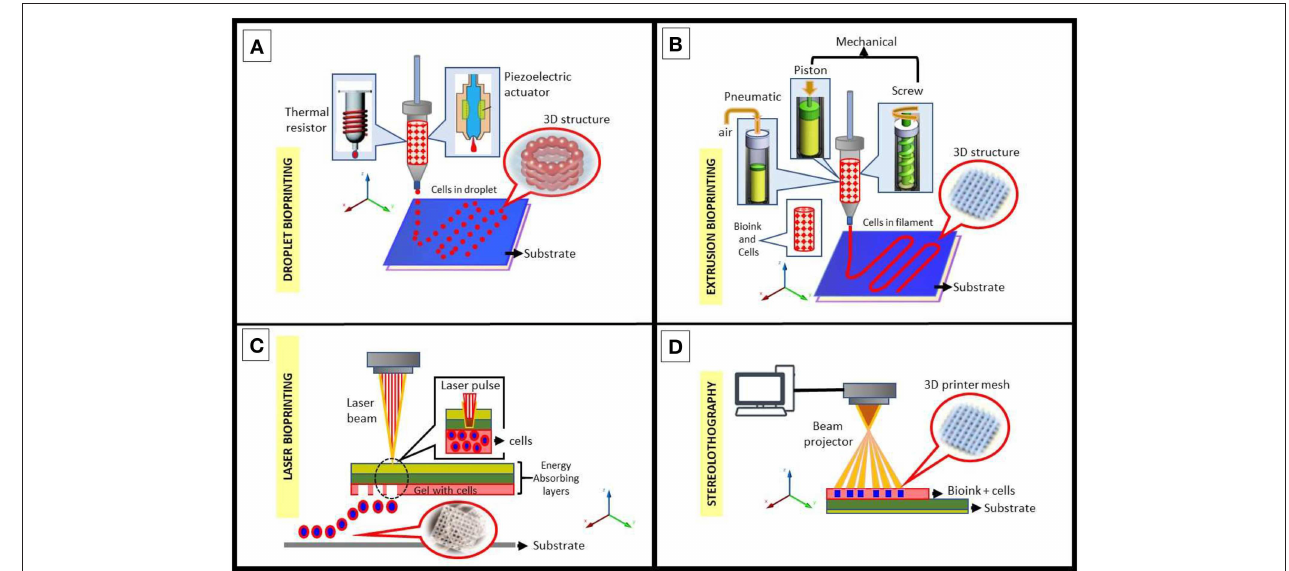
FIGURE 2 | Schematic diagram of common bioprinting methods using bioinks (with and/or without cells). (A) Inkjet printing methods: thermal and piezoelectric; both methods drive droplets through the nozzle for the construction of a 3D structure. (B) Extrusion based methods: pneumatic, piston-driven, screw-driven; these methods guarantee a continuous flow of bioink through the nozzle for the construction of a 3D structure. (C) Laser-assisted bioprinting, a nozzle-free technique consisting of a pulse laser source that deposits micro-droplets of bioink on a substrate for the construction of a 3D structure. (D) Stereolithography using a beam projector where focused light beams allow for precise photopolymerization of layers of light-sensitive polymers to apply any desired pattern to bioink.